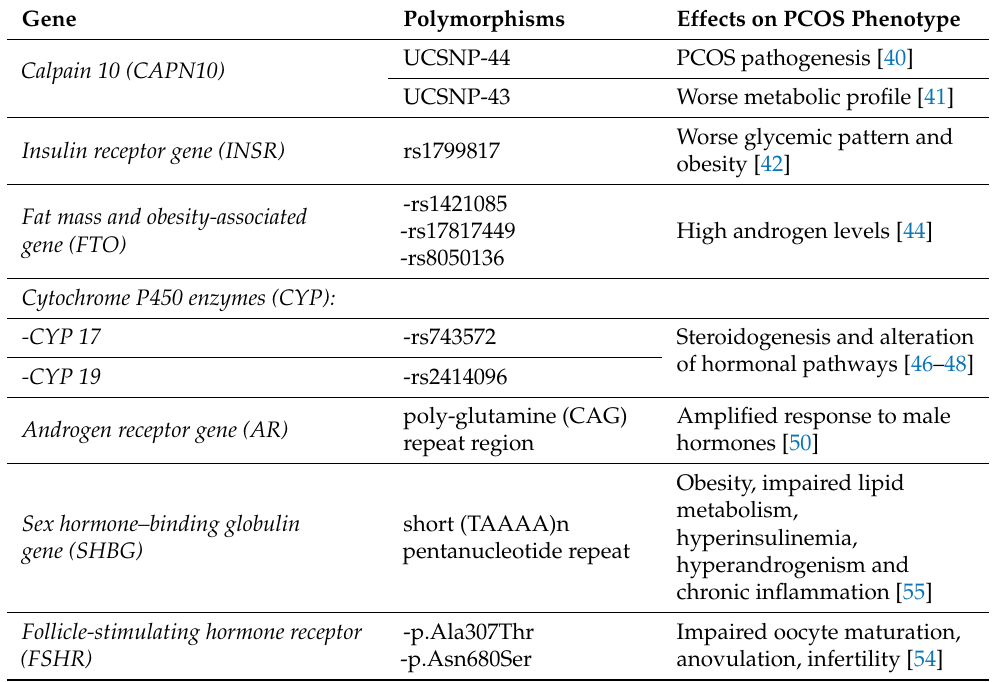
Table 2. Genetic polymorphisms associated to